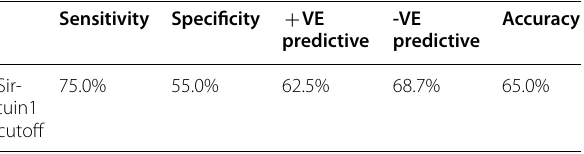
Table 5 Validity of sirtuin 1 for prediction of coronary artery disease Sensitivity Specificity